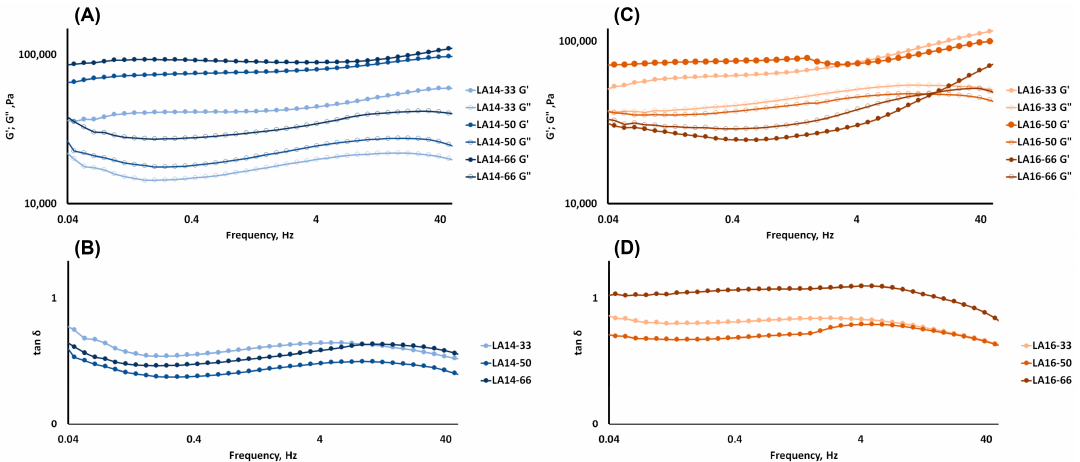
Figure 5. Rheological properties of hydrogels: storage modulus (G ′ ) and loss modulus (G ″ ) test results ( A , C ); tan δ test results ( B , D ) represented as a function of frequency. Void symbols represent the storage modulus G ′ , filled symbols represent the viscous modulus G ″ .